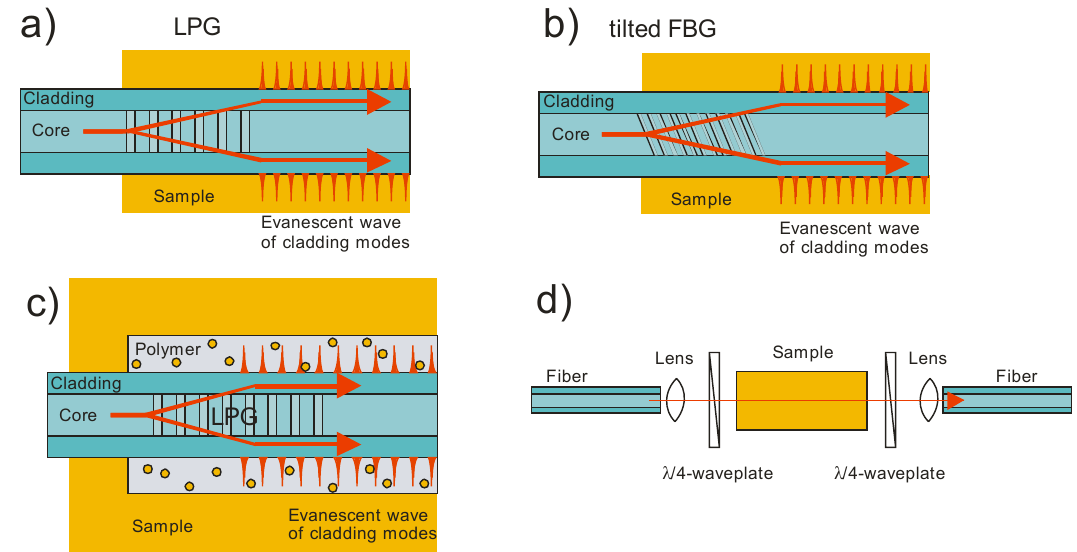
Figure 6. Different sensor elements for refractive index change measurements. Refractive index sensitive elements like (a) long-period gratings (LPG) or (b) tilted fiber Bragg gratings (FBGs) are often used. (c) By coating an LPG with a polymer the sensor element can be made more sensitive and more selective. (d) Circular birefringent samples have different refractive index for left or right circularly polarized light. In this sensor element the linear polarized light from the fiber is converted to circular polarized light by a quarter waveplate before being transmitted through the sample. A second quarter waveplate restores the linear polarization before coupling the light back into the cavity